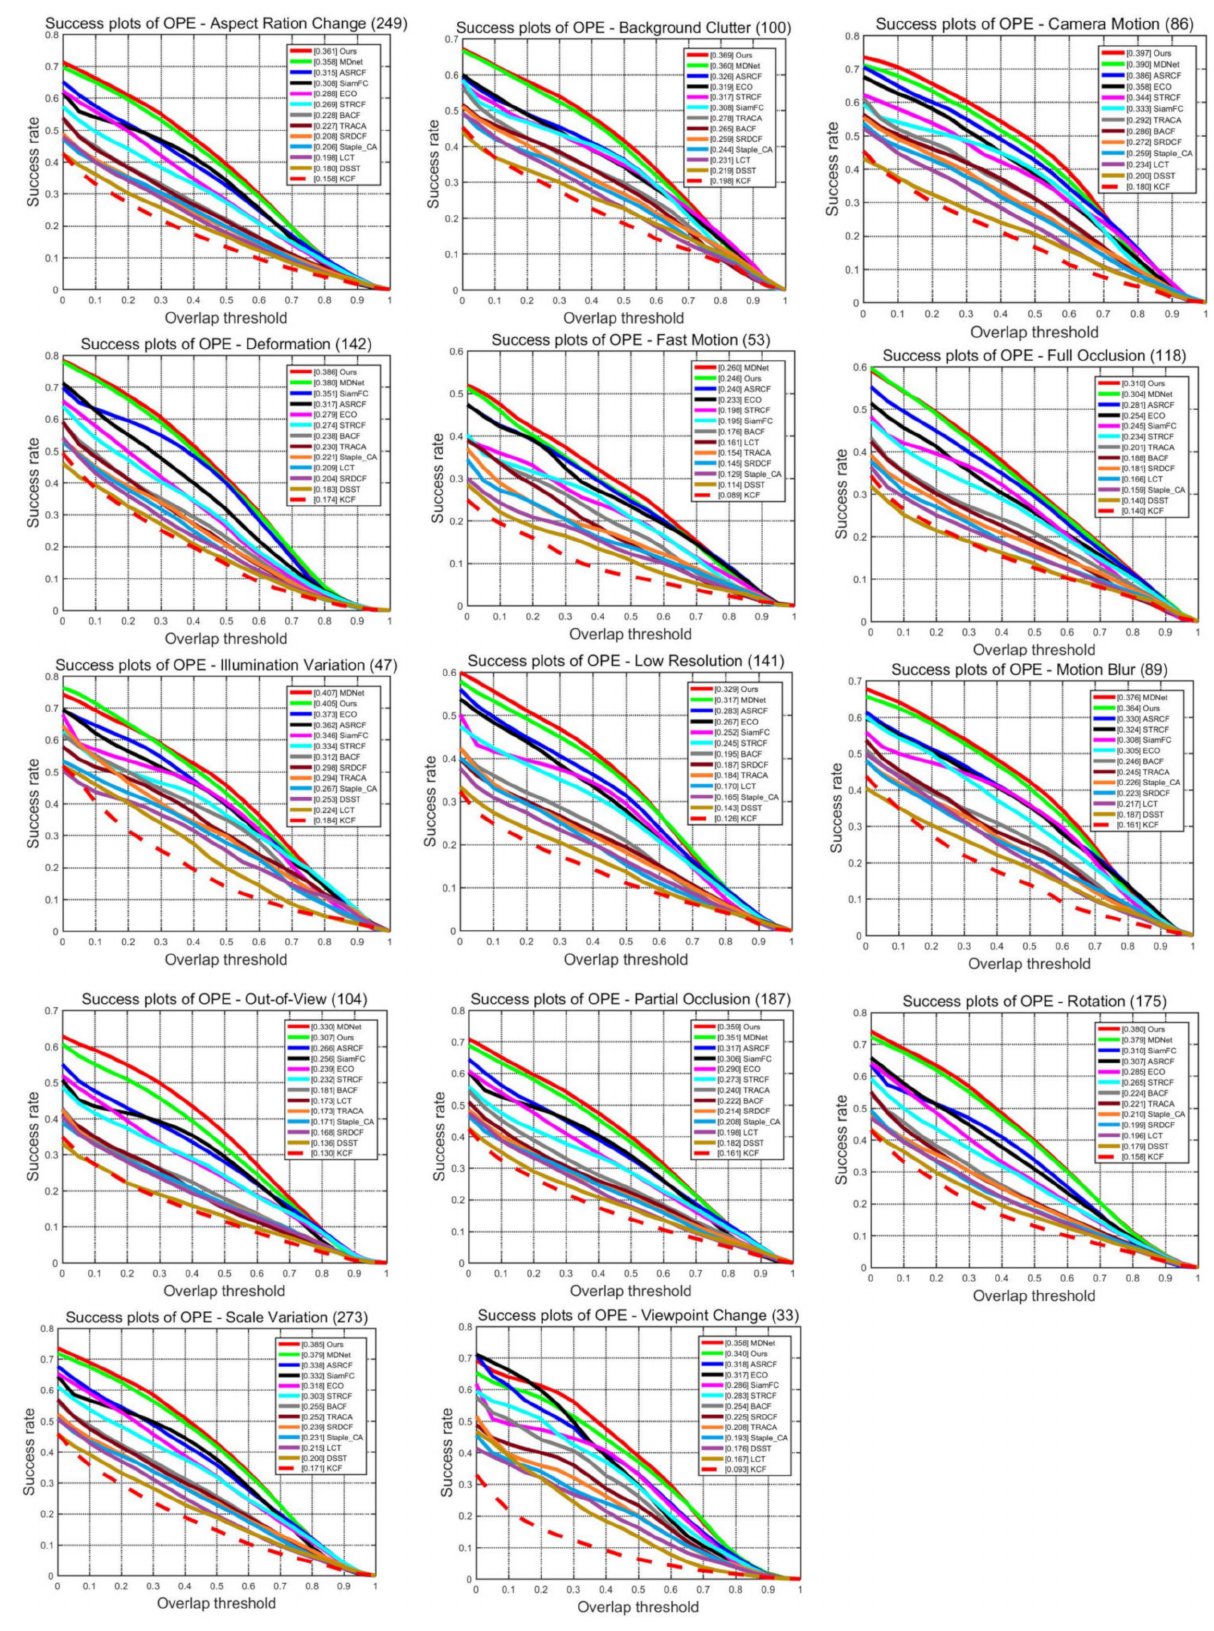
Figure 7. Success plots of OPE evaluate on fourteen sequence